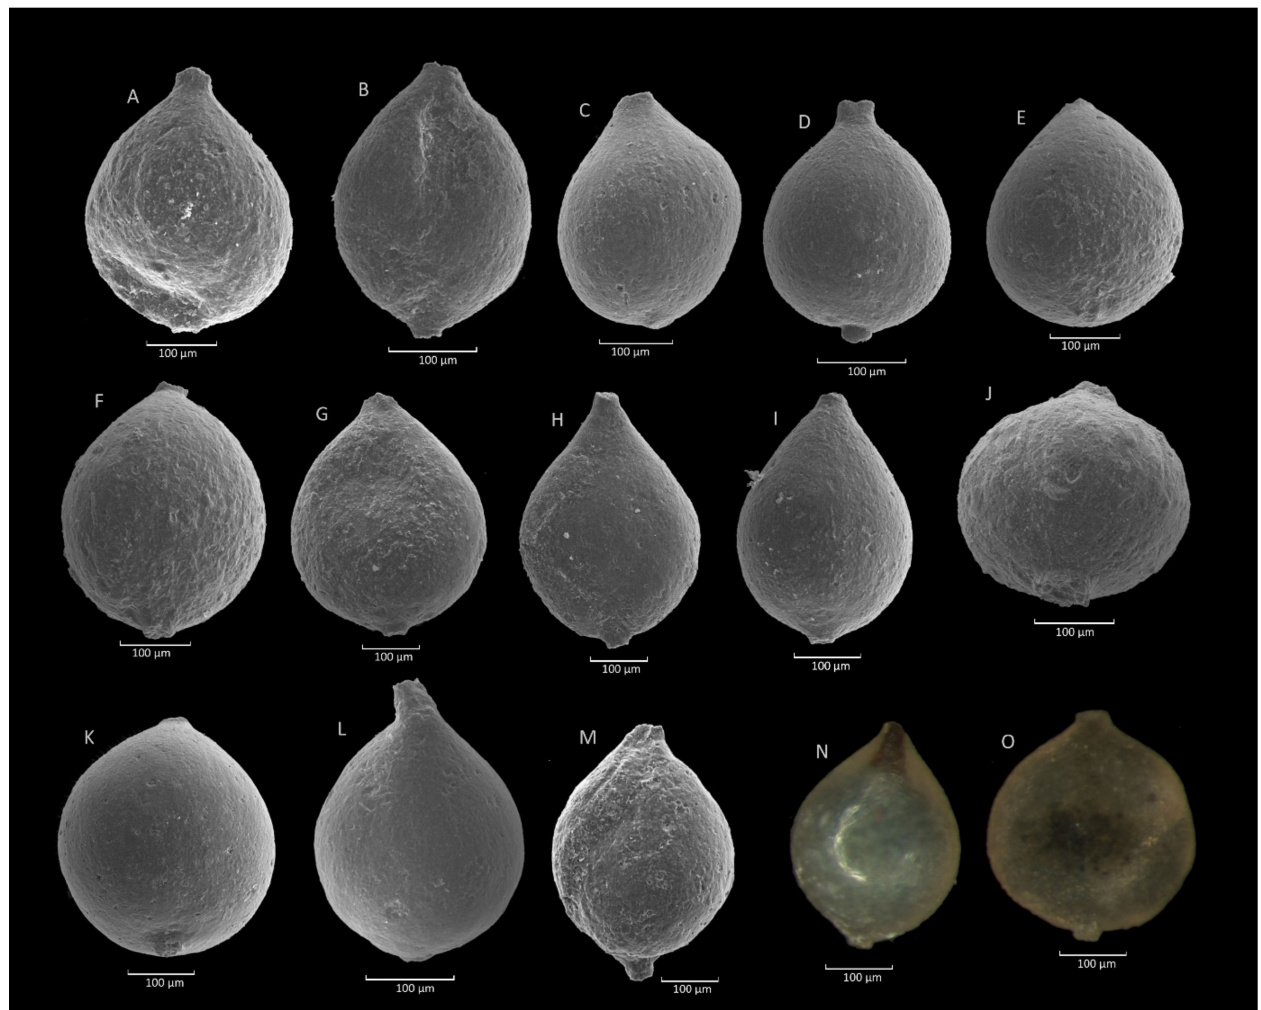
Figure 6. Caudammina ovulum (Grzybowski). ( A ): Szydłowiec section; ( B , D , I , K ): Mutne section; ( C , H ): Rzyczki section; ( E – G ): Gorze´n section; ( J , L ): Zimny Dział section; ( M ): Go´scibia section; ( M – O ): Jaworzynka